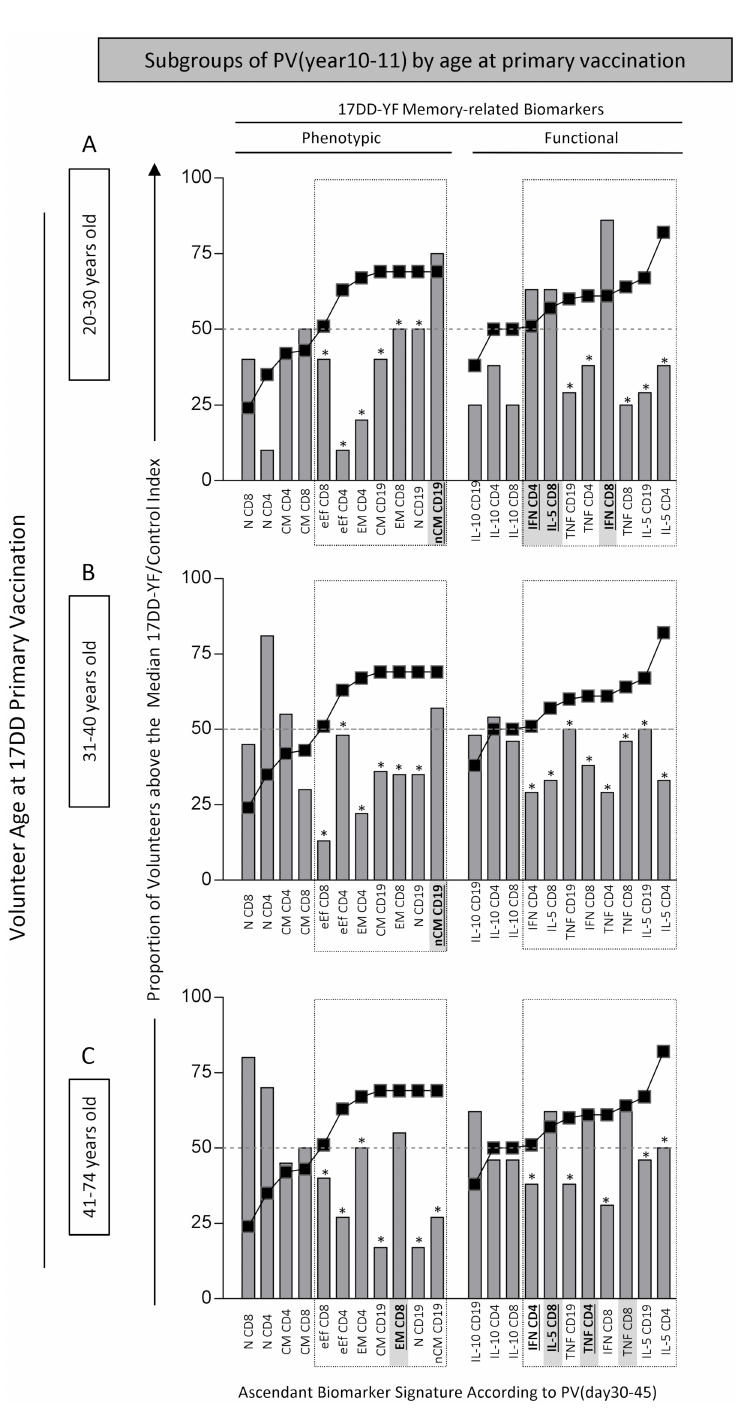
Fig 2. 17DD-YF memory-related biomarker signatures according to the age at primary vaccination. The memory- related biomarker signatures were constructed using the proportion of subjects above the cut-off edges defined for each attribute, calculated as the median index value (17DD-YF/Control) for the study population. The signatures were constructed for phenotypic/functional biomarkers, compiling the proportion (%) of volunteer above the median cut- off indices. The memory-related biomarker signatures, constructed for the PV(day30-45) group, were used as the reference curves for comparative analysis amongst the PV(year10-11) subgroups, categorized according to the age at primary vaccination, including (A) 20–30 years old, (B) 31–40 years old and (C) 41–74 years old. Comparative analysis were carried out considering only the set of relevant biomarkers pre-selected from the phenotypic/functional